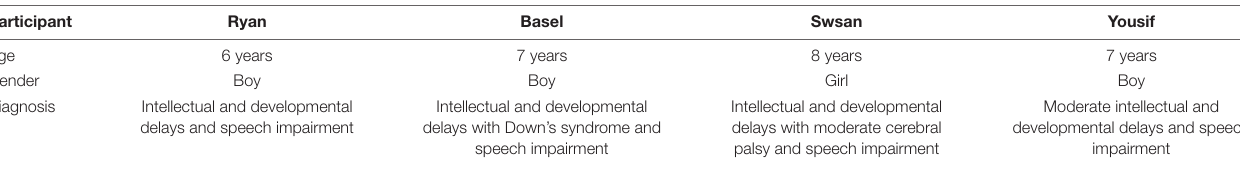
TABLE 1 | Participant’s